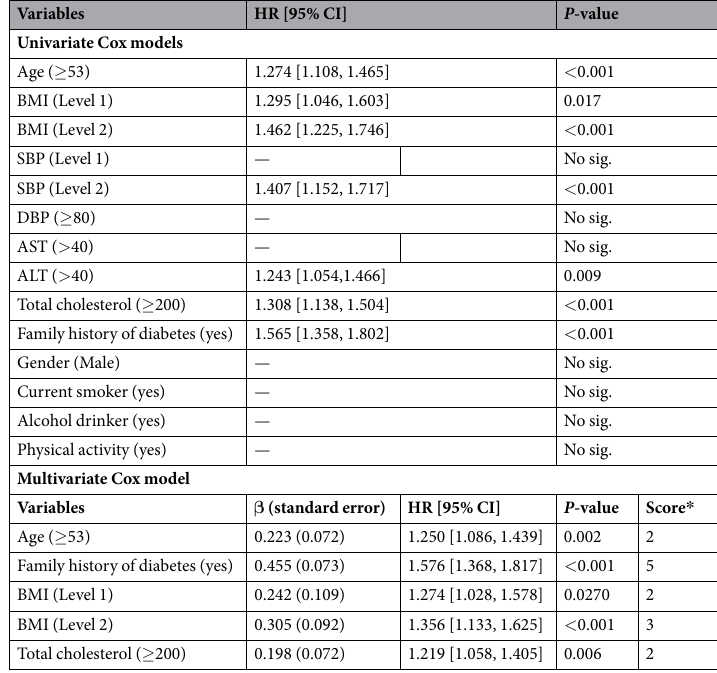
Table 2. Results of univariate and multivariate Cox proportional hazards models. * Each score was computed by dividing the value of each coefficient by the minimum value ( β total cholesterol = 0.198) and multiplying it by a constant (k =